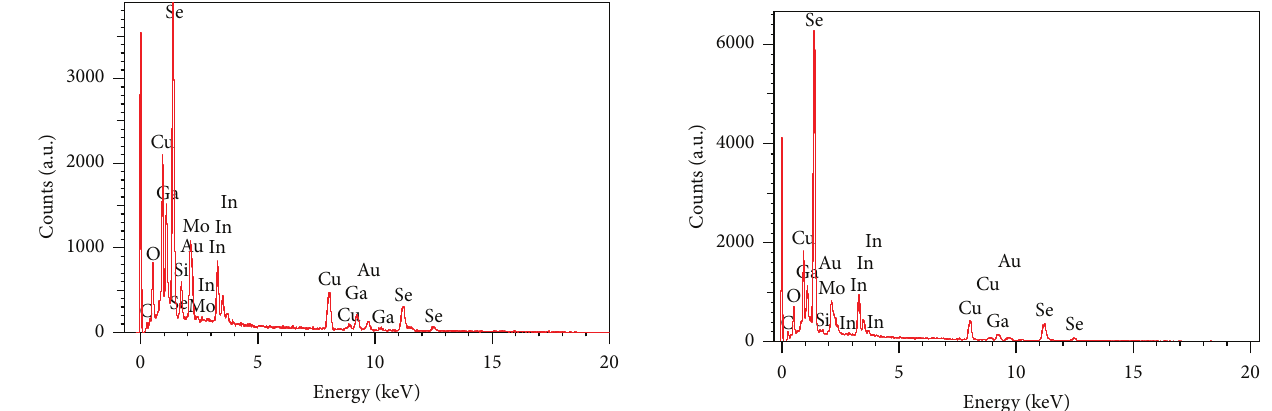
Figure 4: EDS photograph of CIGS sample sintered at 520 ∘ C for 30